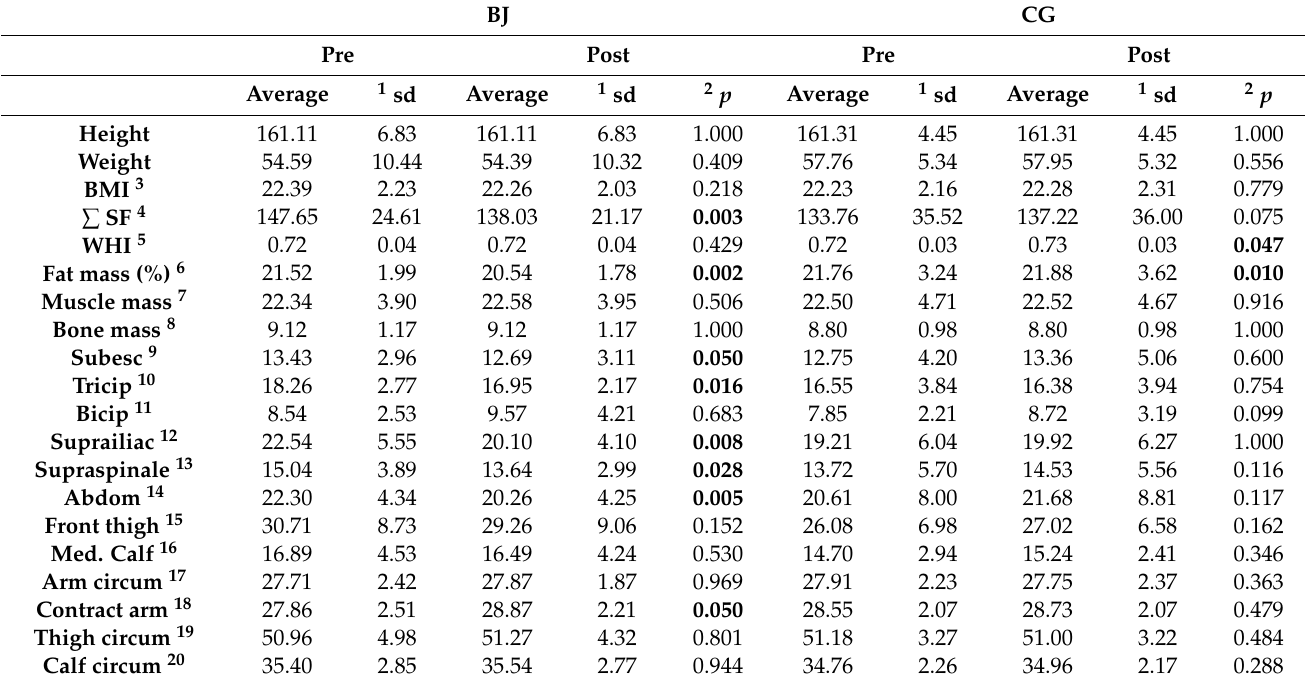
Table 4. Pre- and post-test results of variables related to body